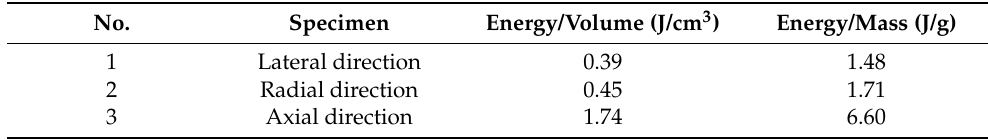
Table 2. Welded origami honeycomb data